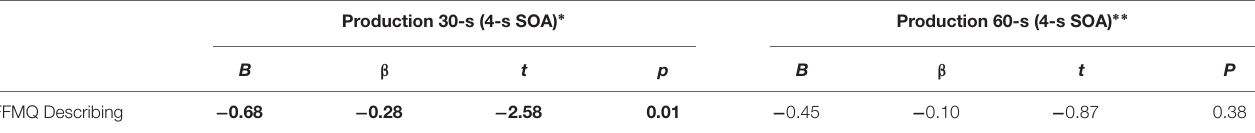
TABLE 6 | Multiple linear regression analysis between production tasks (4-s SOA conditions) and significant psychological